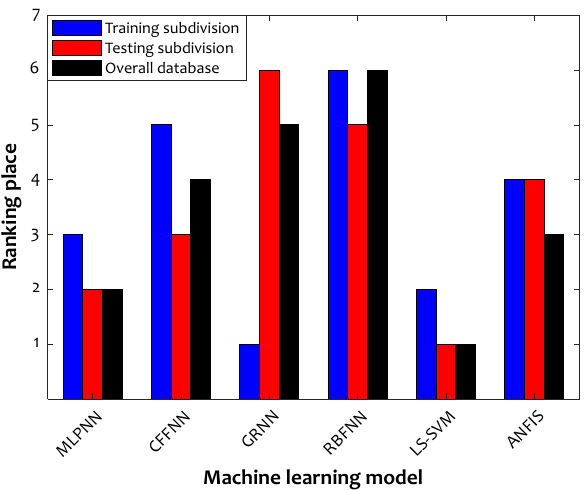
Figure 4. Developed models ranking based on seven different statistical indices.